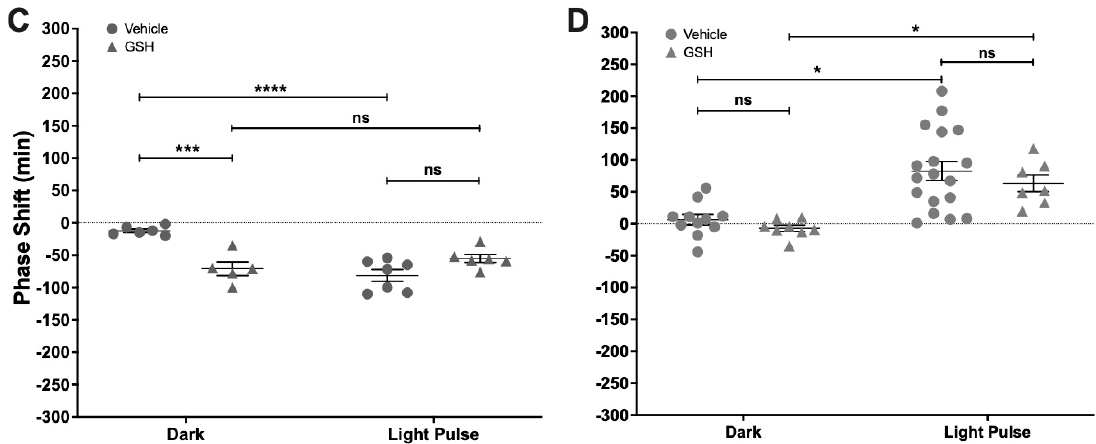
Figure 4. Effect of antioxidants N-acetylcysteine (NAC) and glutathione (GSH) on circadian phase changes. Groups of hamsters in constant darkness conditions were treated with an i.c.v injection of either NAC (2 µ L, 100 µ M, or vehicle) ( A , B ) or GSH (1 µ L, 100 µ M) ( C , D ), 5 min before a subsaturant light pulse (10 min, 50 lux) delivered at CT14 or CT18. Controls for photic response (Dark) received only pharmacological treatment without light stimuli. Phase changes are shown as mean ± SEM. Two-way ANOVA, followed by Tukey’s multiple comparisons test, ns = not significant; * p < 0.05; *** p < 0.001; **** p < 0.0001; for NAC experiment at CT14: vehicle Dark n = 7, vehicle LP n = 8, NAC Dark n = 7, NAC LP n = 8; at CT18: vehicle Dark n = 6, vehicle LP n = 8, NAC Dark n = 10, NAC LP n = 7. For GSH experiment at CT14: vehicle Dark n = 6, vehicle LP n = 7, GSH Dark n = 5, GSH LP n = 6; at CT18: vehicle Dark n = 11, vehicle LP n = 17, GSH Dark n = 8, GSH LP n =